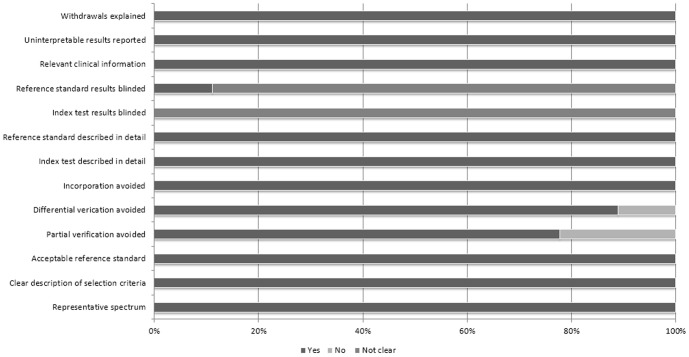
Quality assessement with 13-items modified QUADAS tool.